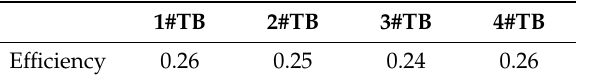
Table 3. Parameters of turbines.